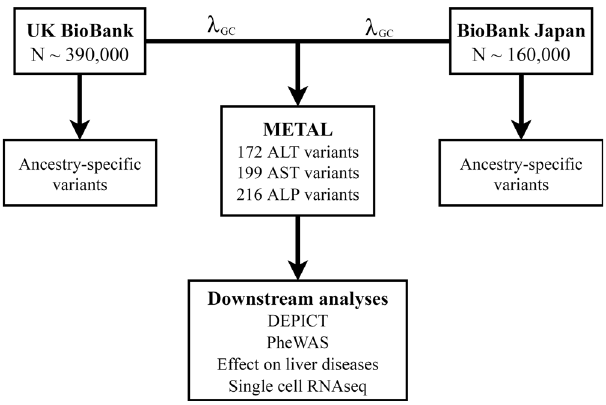
Fig. 1 Study design. METAL is a software package that performs meta- analysis using genome-wide association study summary statistics. ALT, alanine aminotransferase. AST, aspartate aminotransferase. ALP, alkaline phosphatase. DEPICT, Data-driven Expression Prioritization Integration for Complex Traits. PheWAS, phenome-wide association